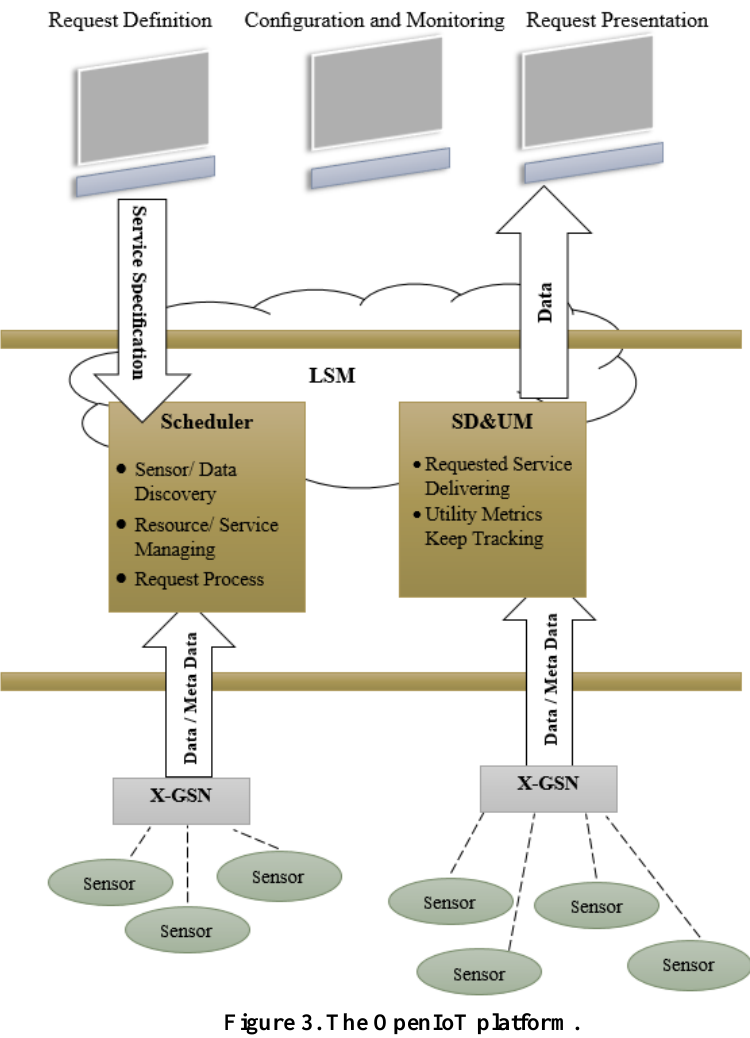
Figure 3. The OpenIoT